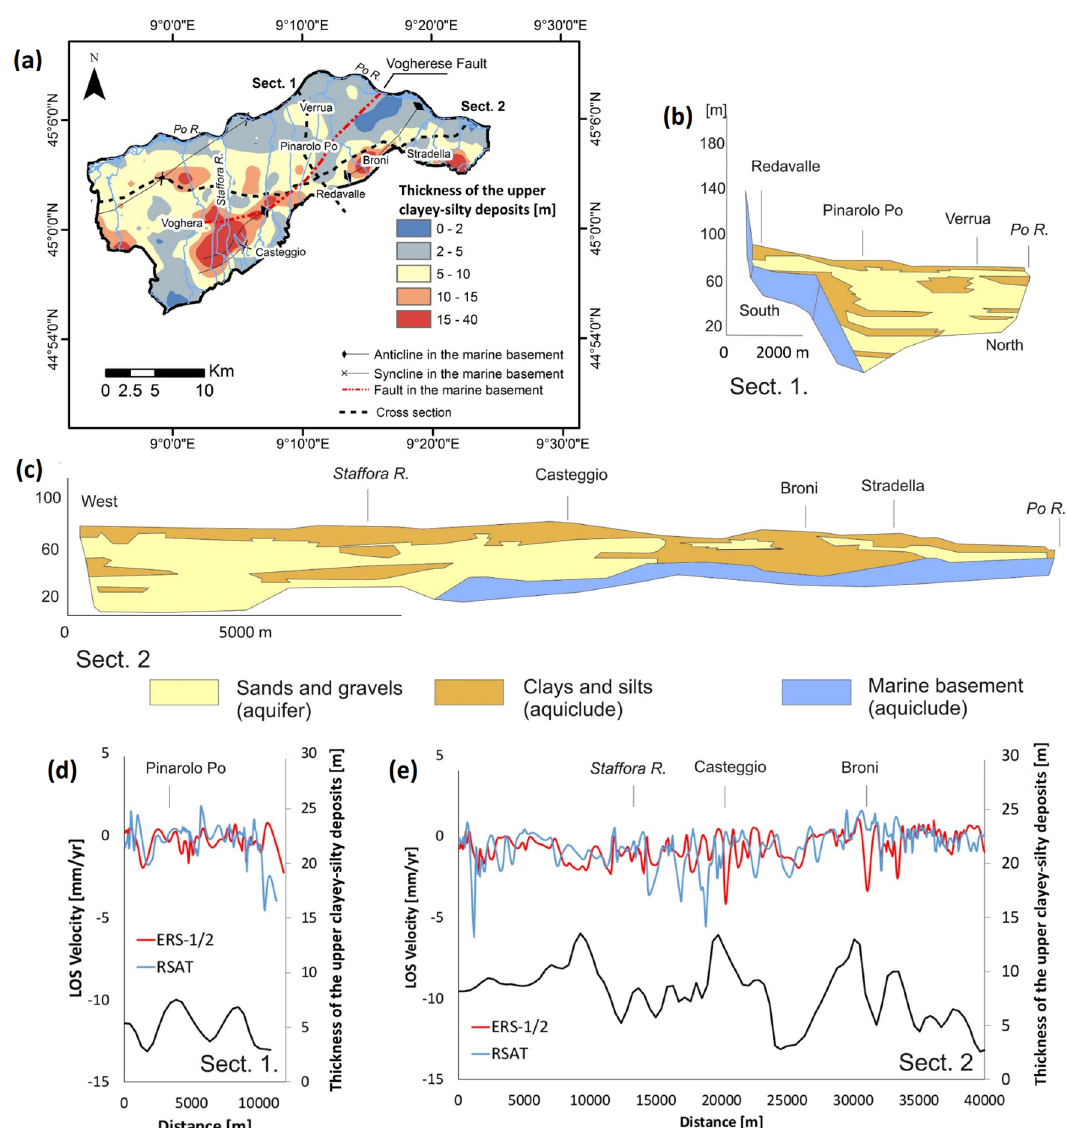
Figure 8. ( a ) Thickness of the upper clayey-silty deposits (modified from Pilla et al., 2007 [21]). Hydrogeological sections 1 ( b ) and 2 ( c ), simplified from Cavanna et al. (1998) [17]. Relationship between the average LOS velocity detected by ERS-1/2 asc. and Radarsat (RSAT) desc. sensors, and the thickness of the upper clayey-silty deposits along sections 1 ( d ) and 2 ( e ).